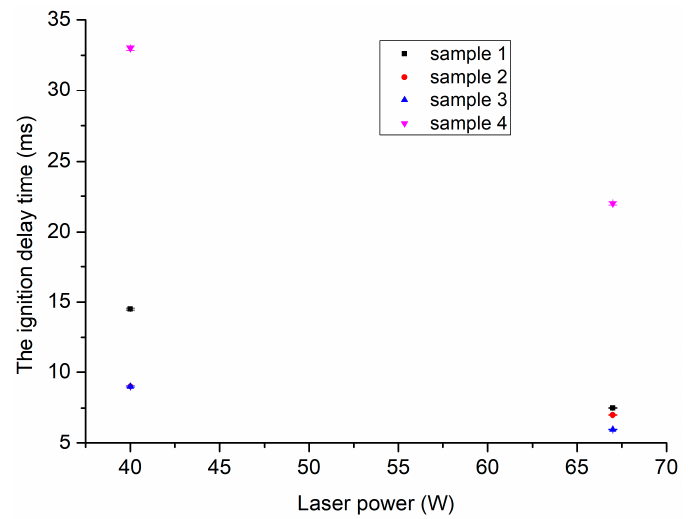
Figure 7. The ignition delay time of samples 1, 2, 3, and 4.